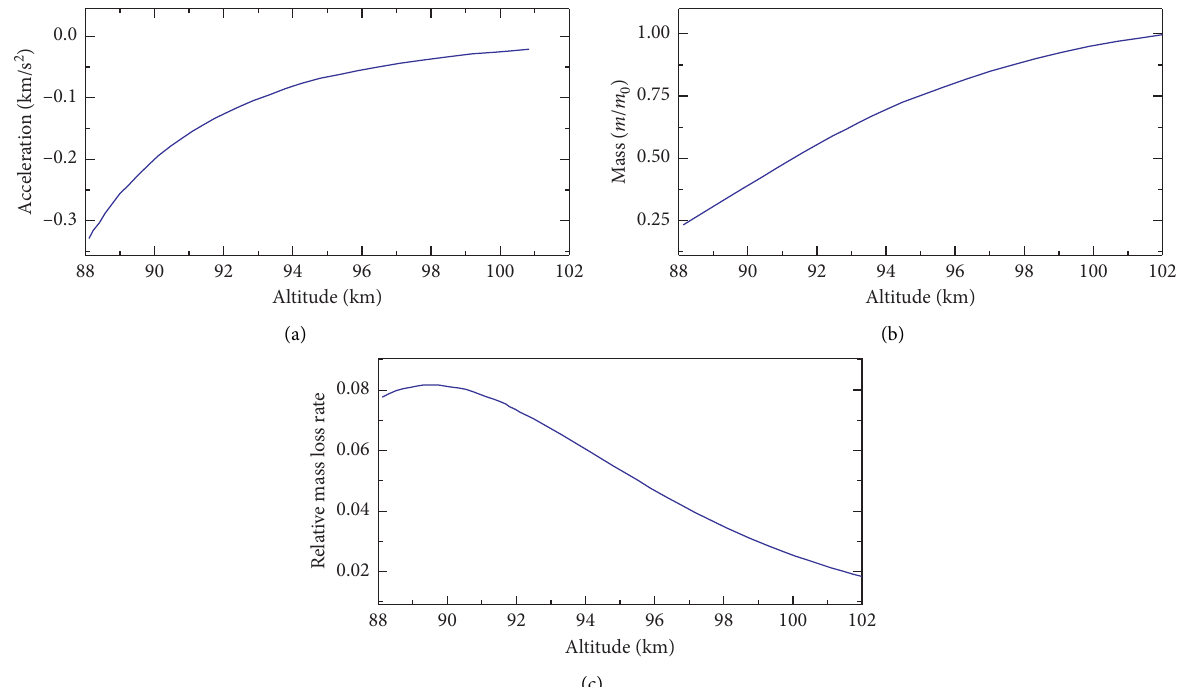
Figure 5: Curves of the acceleration (a), mass evolution (b), and relative mass loss rate (c) as a function of altitude for the meteoroid